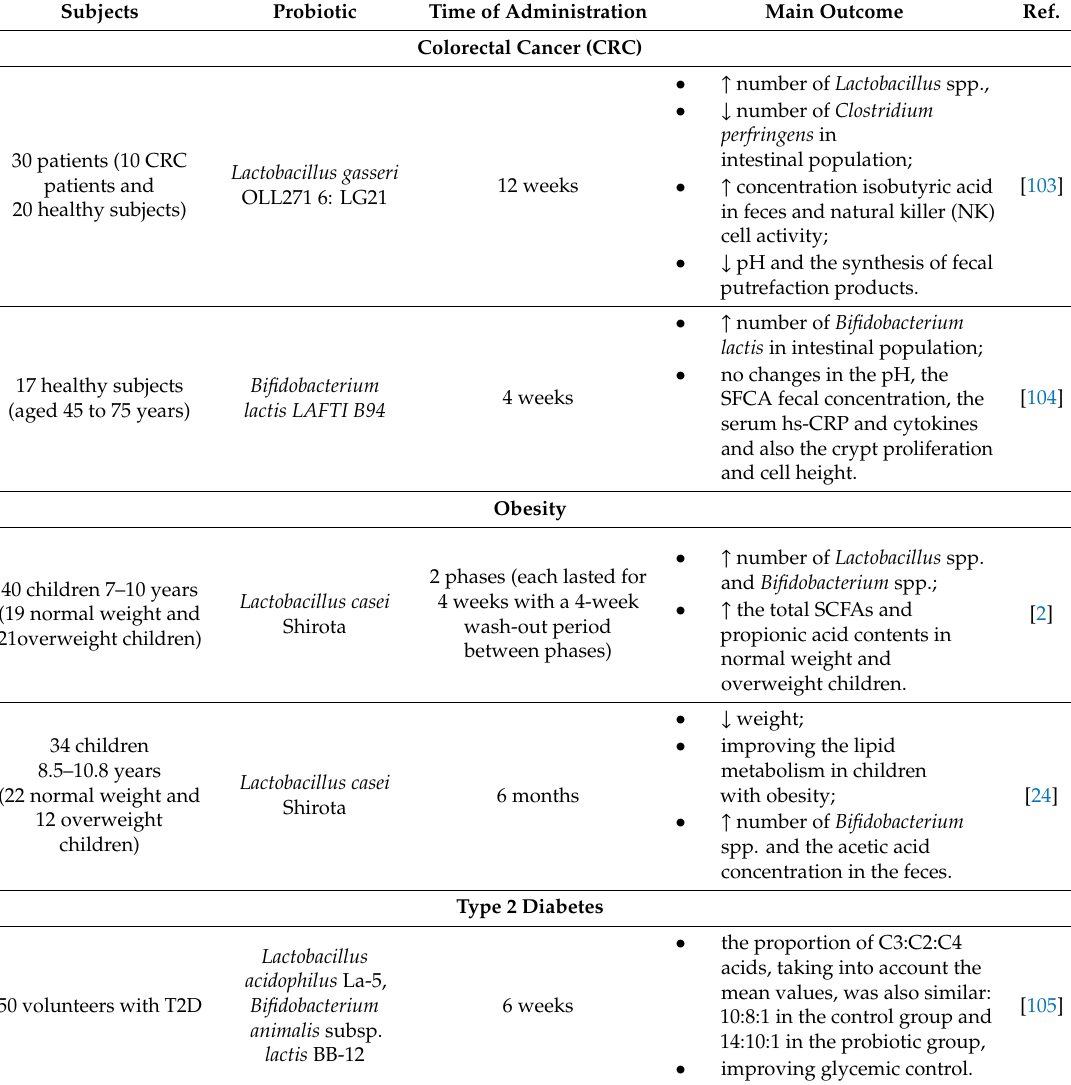
Table 5. Examples of clinical trials regarding the e ff ect of probiotics on SCFAs production by human intestinal